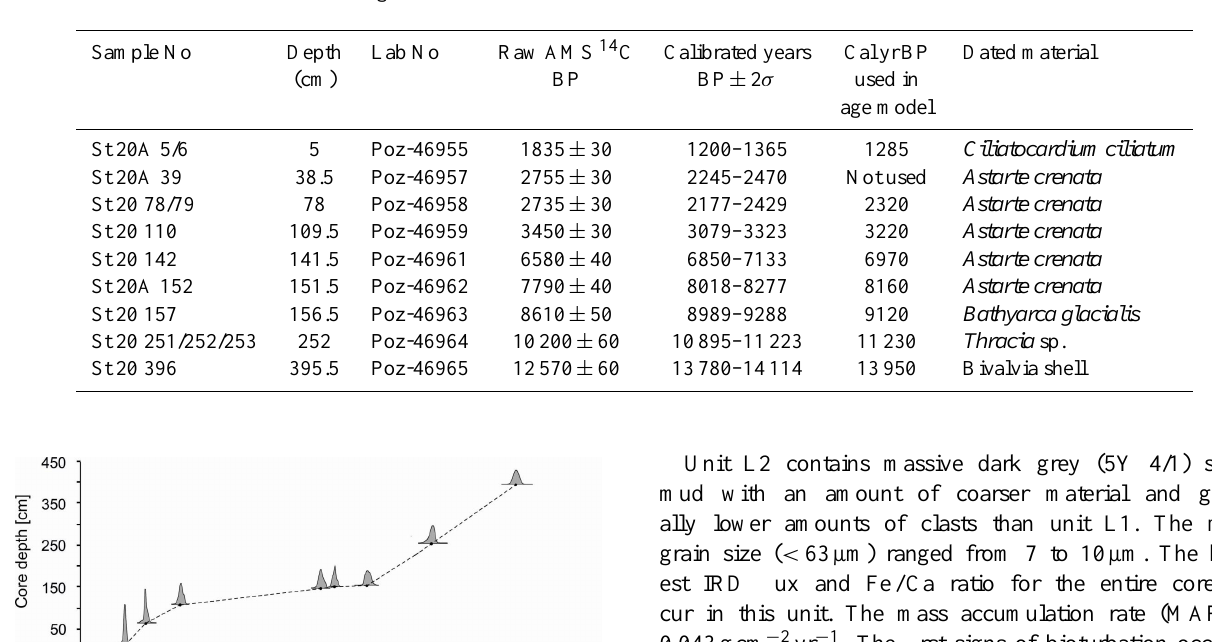
Table 2. AMS 14 C dates and calibrated ages.